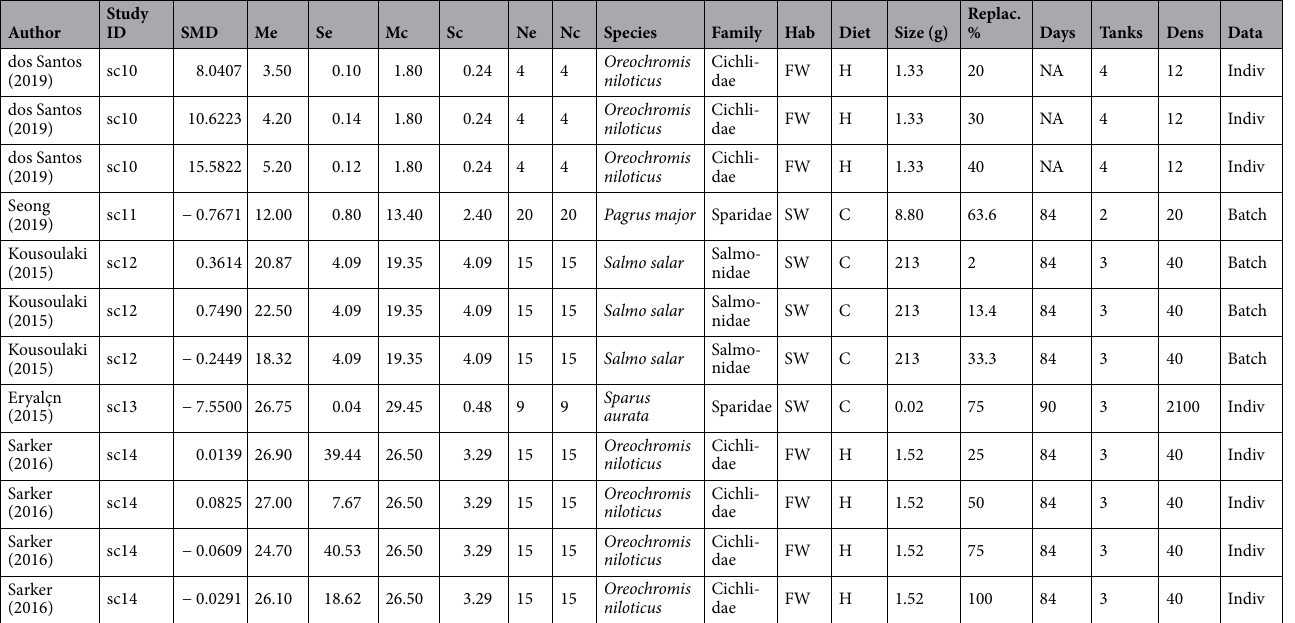
Table 3. Results of feeding studies assessing the effects of Schizochytrium replacement on the omega-3 content of the fish fillet. SMD standardized mean difference, Me mean omega-3 content of experimental